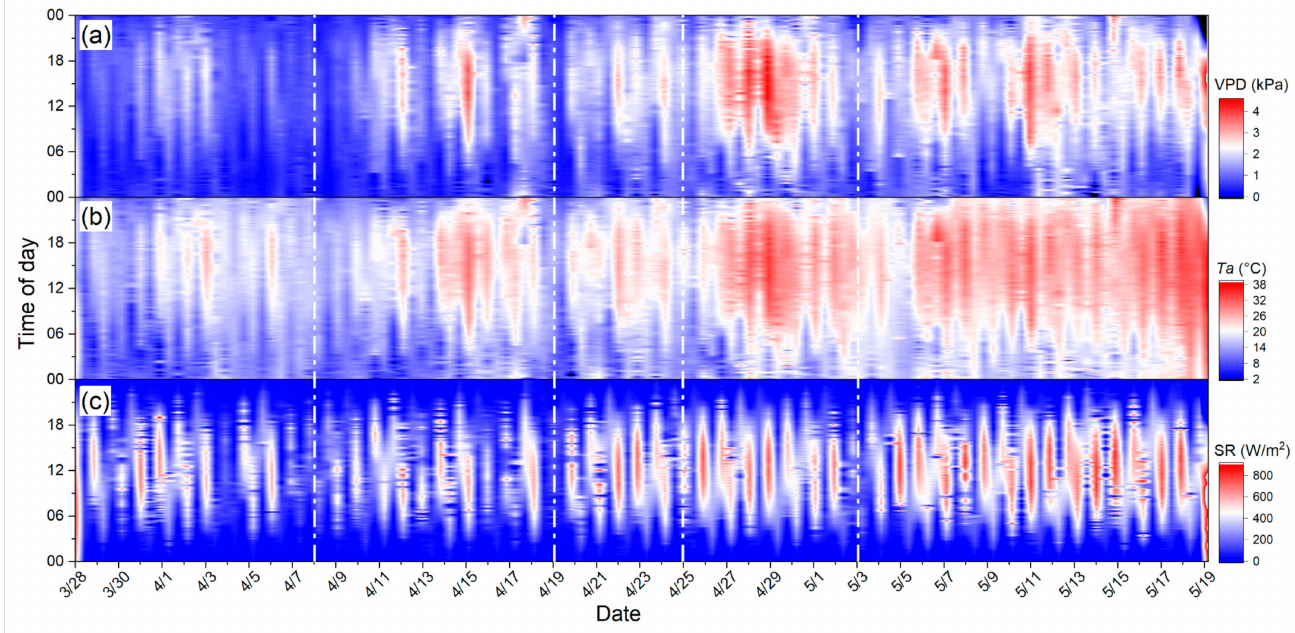
Figure 3. Overview of the meteorological conditions during the entire measurement campaign (from 28 March 2017 to 19 May 2017): ( a ) vapor pressure deficit (VPD, kPa), ( b ) air temperature (Ta, ◦ C), and ( c ) solar radiation (SR, W/m 2 ). White dash-dotted lines in panels ( a – c ) show several valleys of SR during the growing